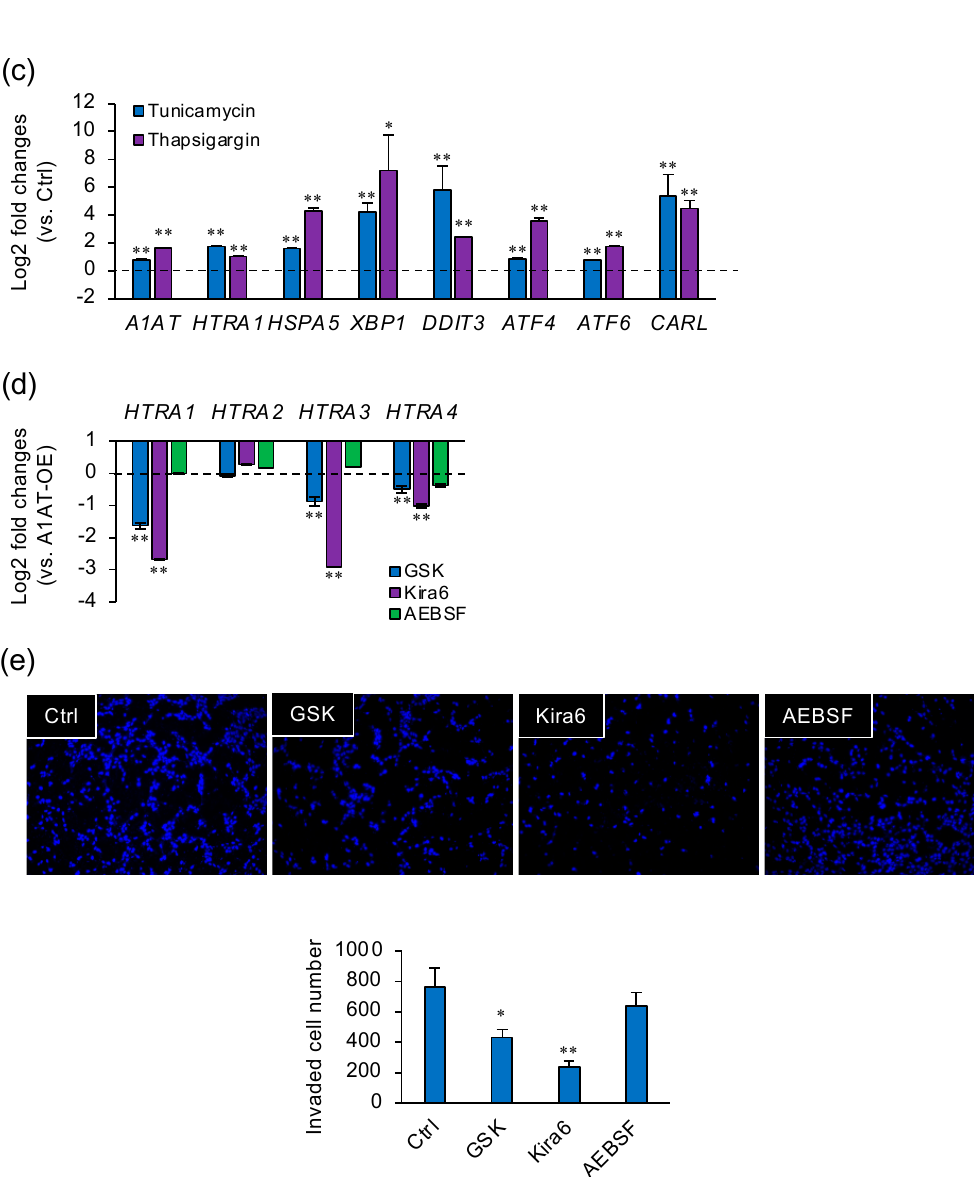
Figure 3. A1AT-induced HTRA1 expression and cell invasion are regulated by unfolded protein response (UPR) signaling. ( a ) The mRNA expression of endoplasmic reticulum (ER) stress markers in HTR8/SVneo cells that had been transfected with A1AT-OE was measured. GAPDH was used as the reference gene. The values are the means ± SEMs of three independent experiments. * p < 0.05, ** p < 0.01. ( b ) The protein levels of ER stress markers were measured by